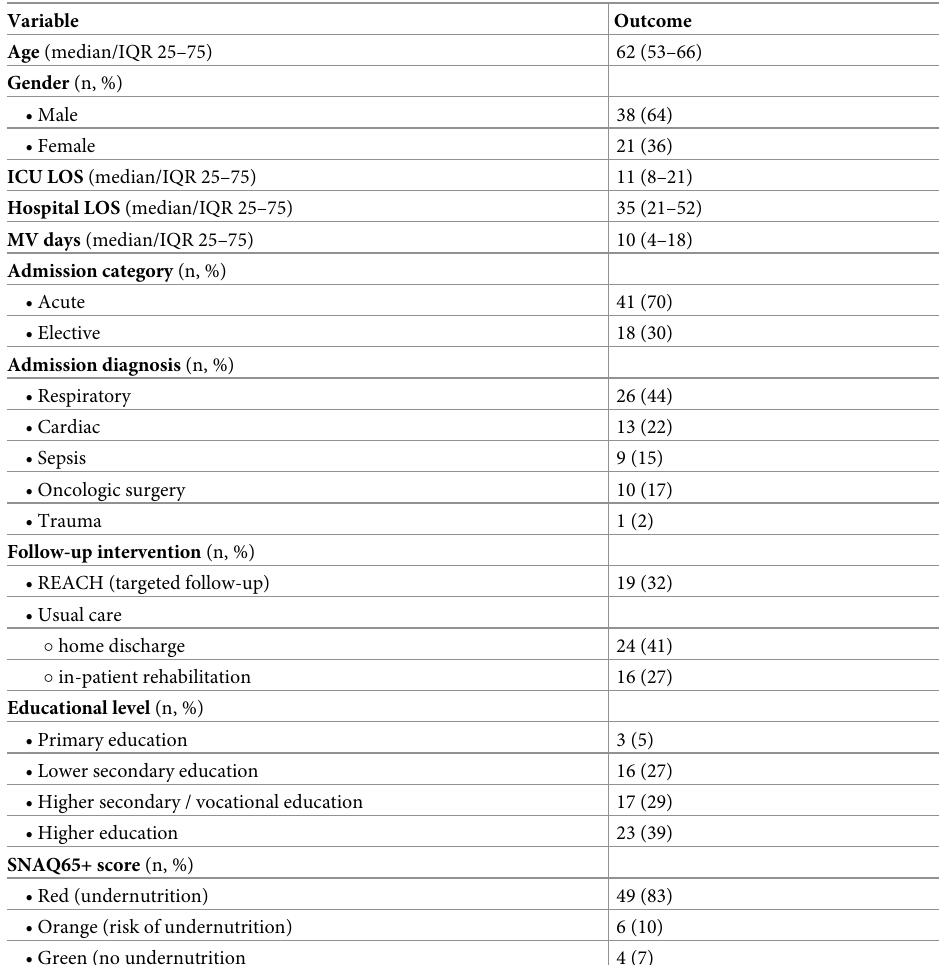
Table 1. Sample characteristics (N =